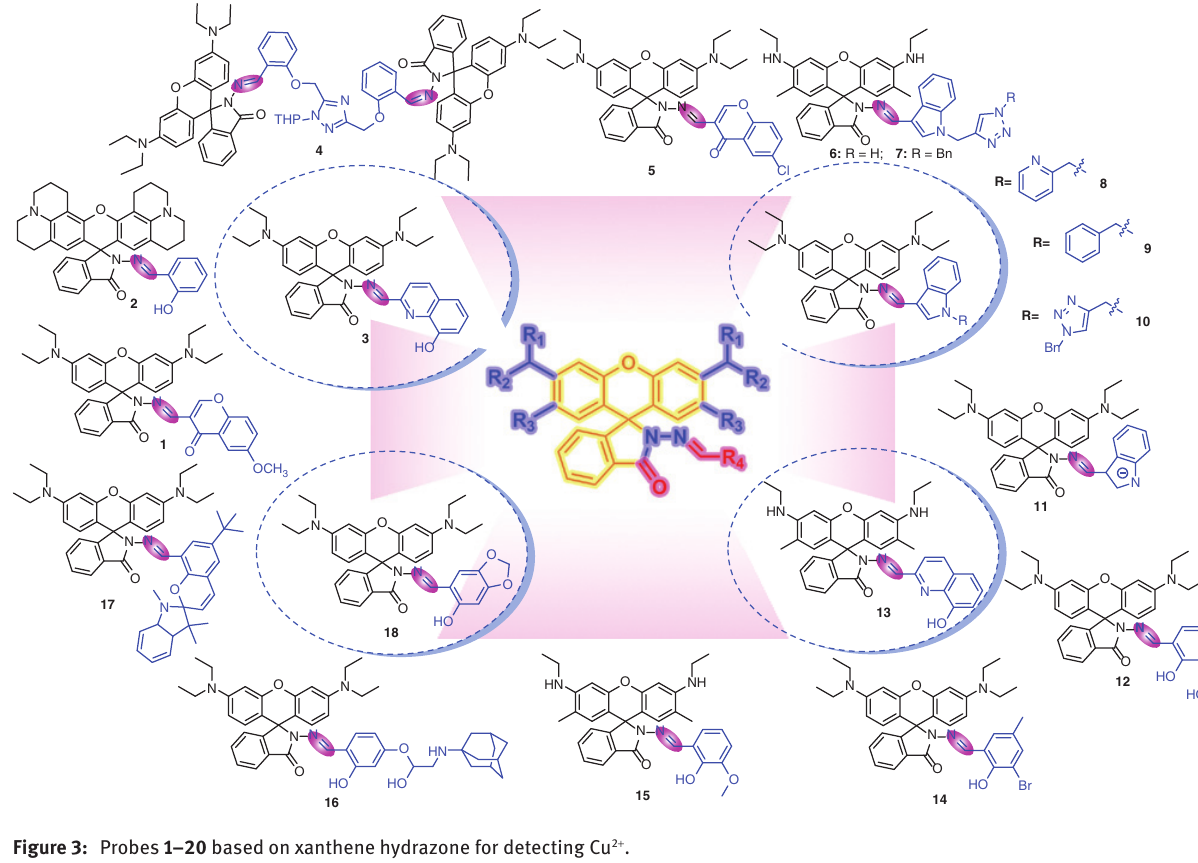
Figure 3: Probes 1–20 based on xanthene hydrazone for detecting Cu 2 + .